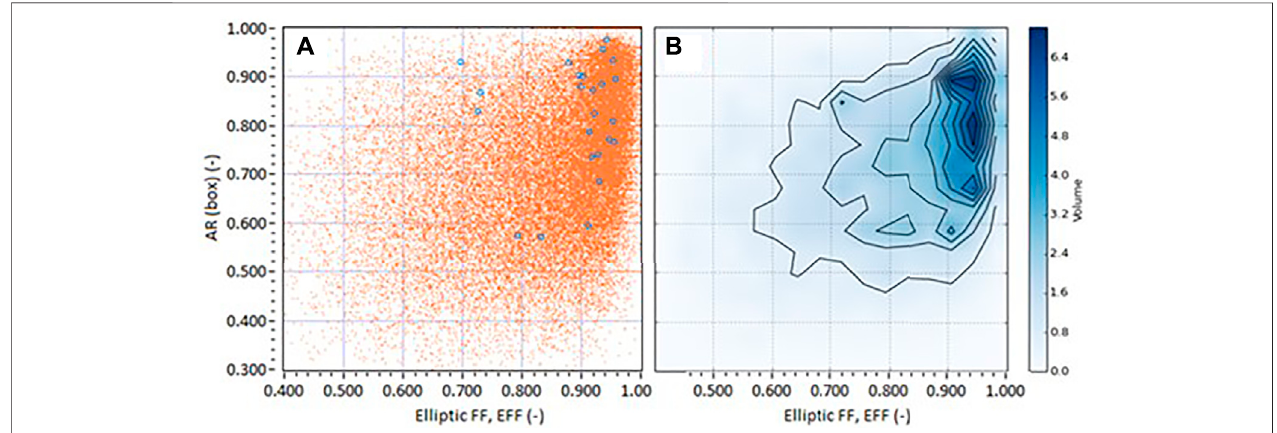
FIGURE 3 | Fly ash particle shape distribution shown as (A) general scatter plot and (B) contour map. The orange dots in (A) represent the particles in the primary mode of the split distribution; the blue circles represent the coarse mode particles.